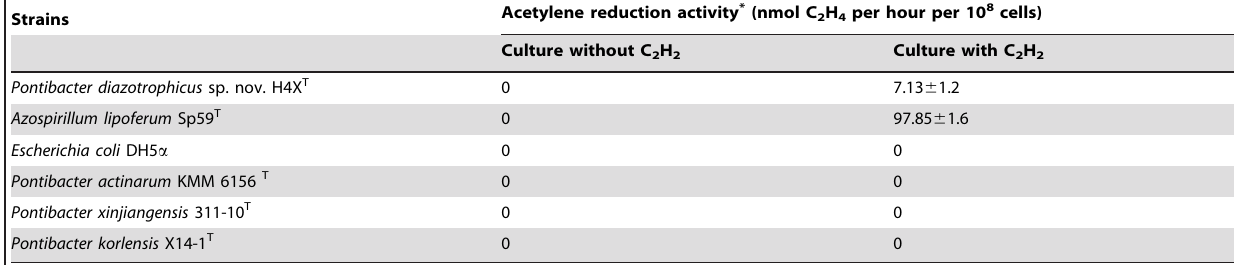
Table 3. Nitrogenase activity detected with acetylene reduction assay.